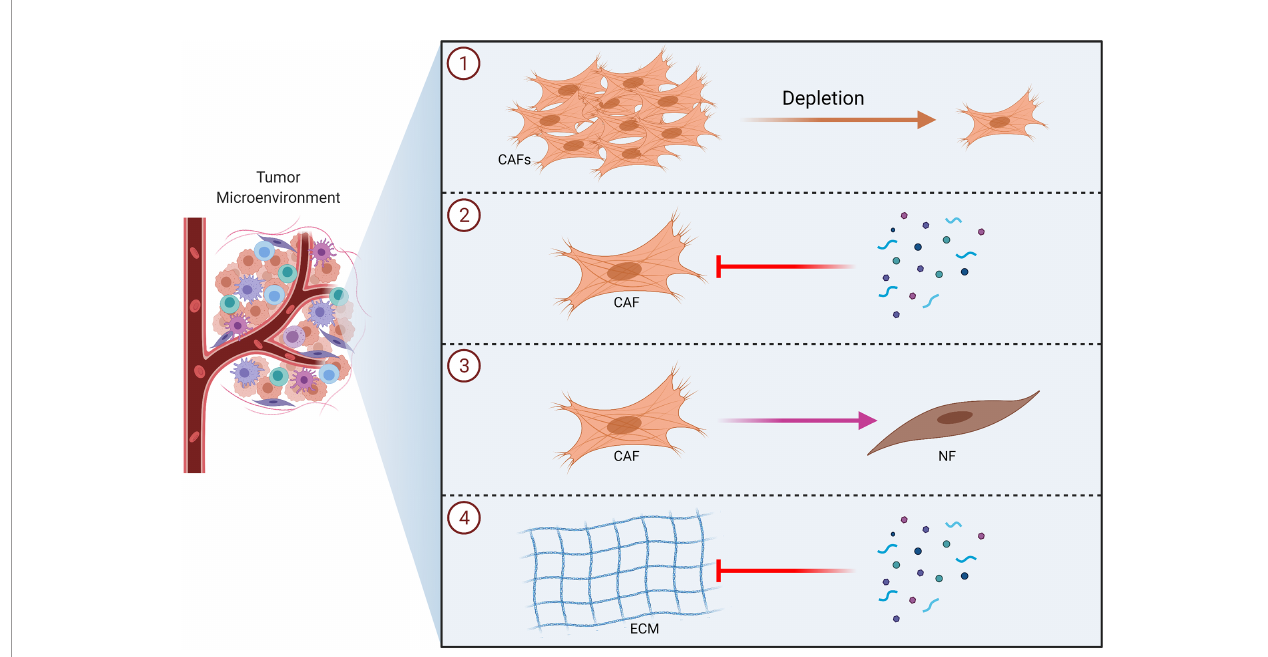
FIGURE 5 | Therapeutic Strategies to Target CAFs in Tumors. Schematic illustrations of the CAF-targeting approaches including depletion of CAFs ① , blocking CAF functions ② , altering CAF activation status ③ and targeting ECM ④ are shown. CAF, cancer associated fi broblast; ECM, extracellular matrix; NF, normal fi